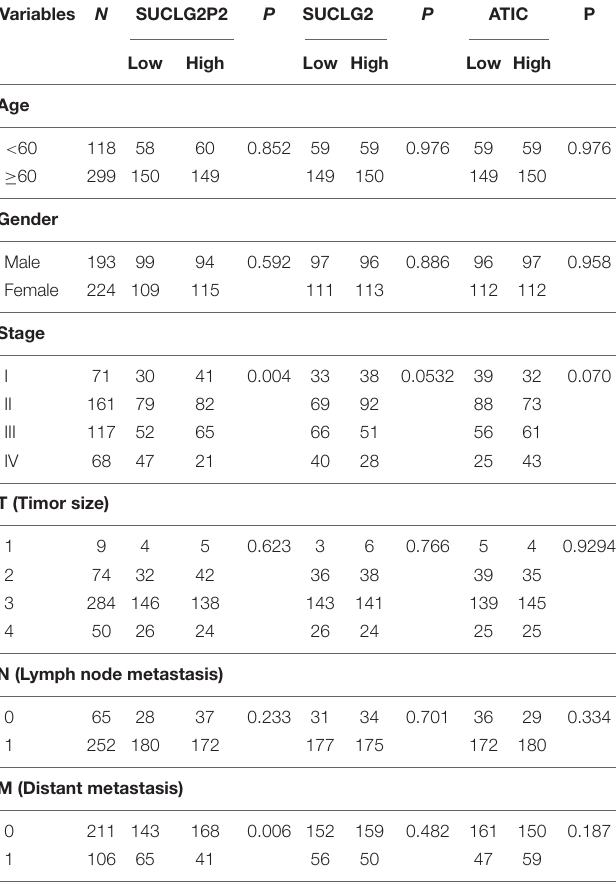
TABLE 4 | Association between SUCLG2P2, SUCLG2 and ATIC genes and clinicopathological parameters of colon cancer patients. Variables